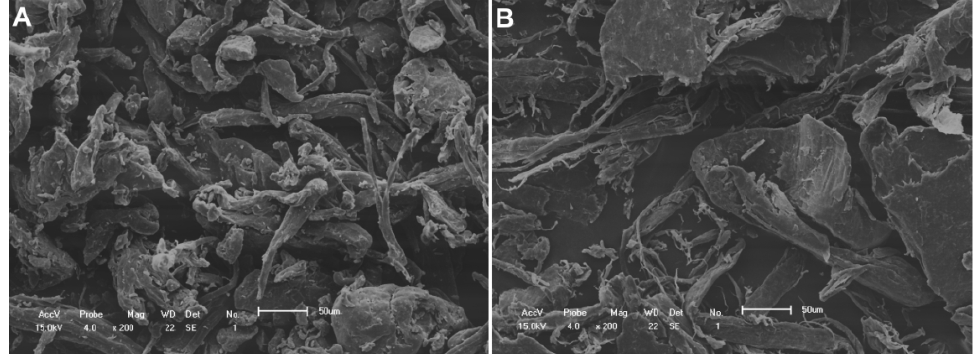
Figure 2. SEM images. ( A ) Alginate powder; ( B ) Chitosan powder; ( C ) Spray-dried alginate microparticles containing pomegranate extract; ( D ) Spray-dried chitosan microparticles containing pomegranate extract. Size bars: 50 µm in figures ( A ) and ( B ); 10 µm in figures ( C ) and ( D